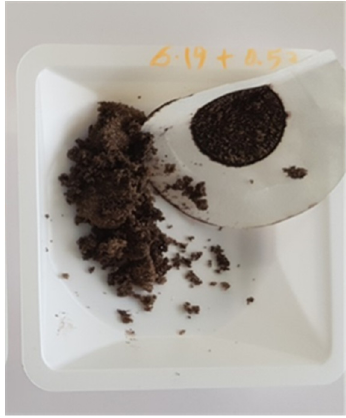
Figure 4. PA batch crystallized in the presence of the PAP impurity.